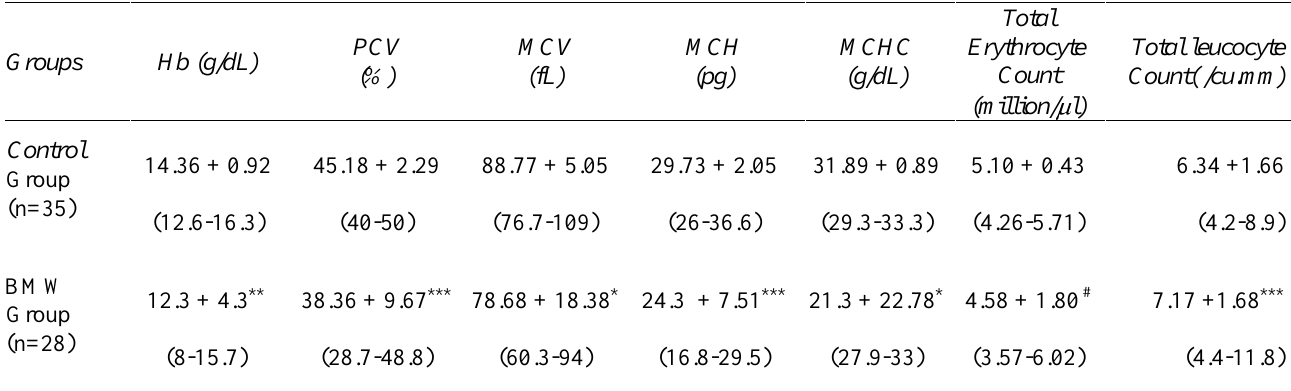
Figure 3: Relationship between blood lead concentration (Pb- B; range is 2.8 -22.0 µg/dl) and d- aminolevulinic acid in urine (ALA-U) of control group of subjects belong to western Maharashtra (India); n = 35, Correlation coefficient (r) is 0.02, p>1.0, Not significant; y = -0.0337x + 10.065. Table 2 : Hematological parameters in the battery manufacturing workers and control group